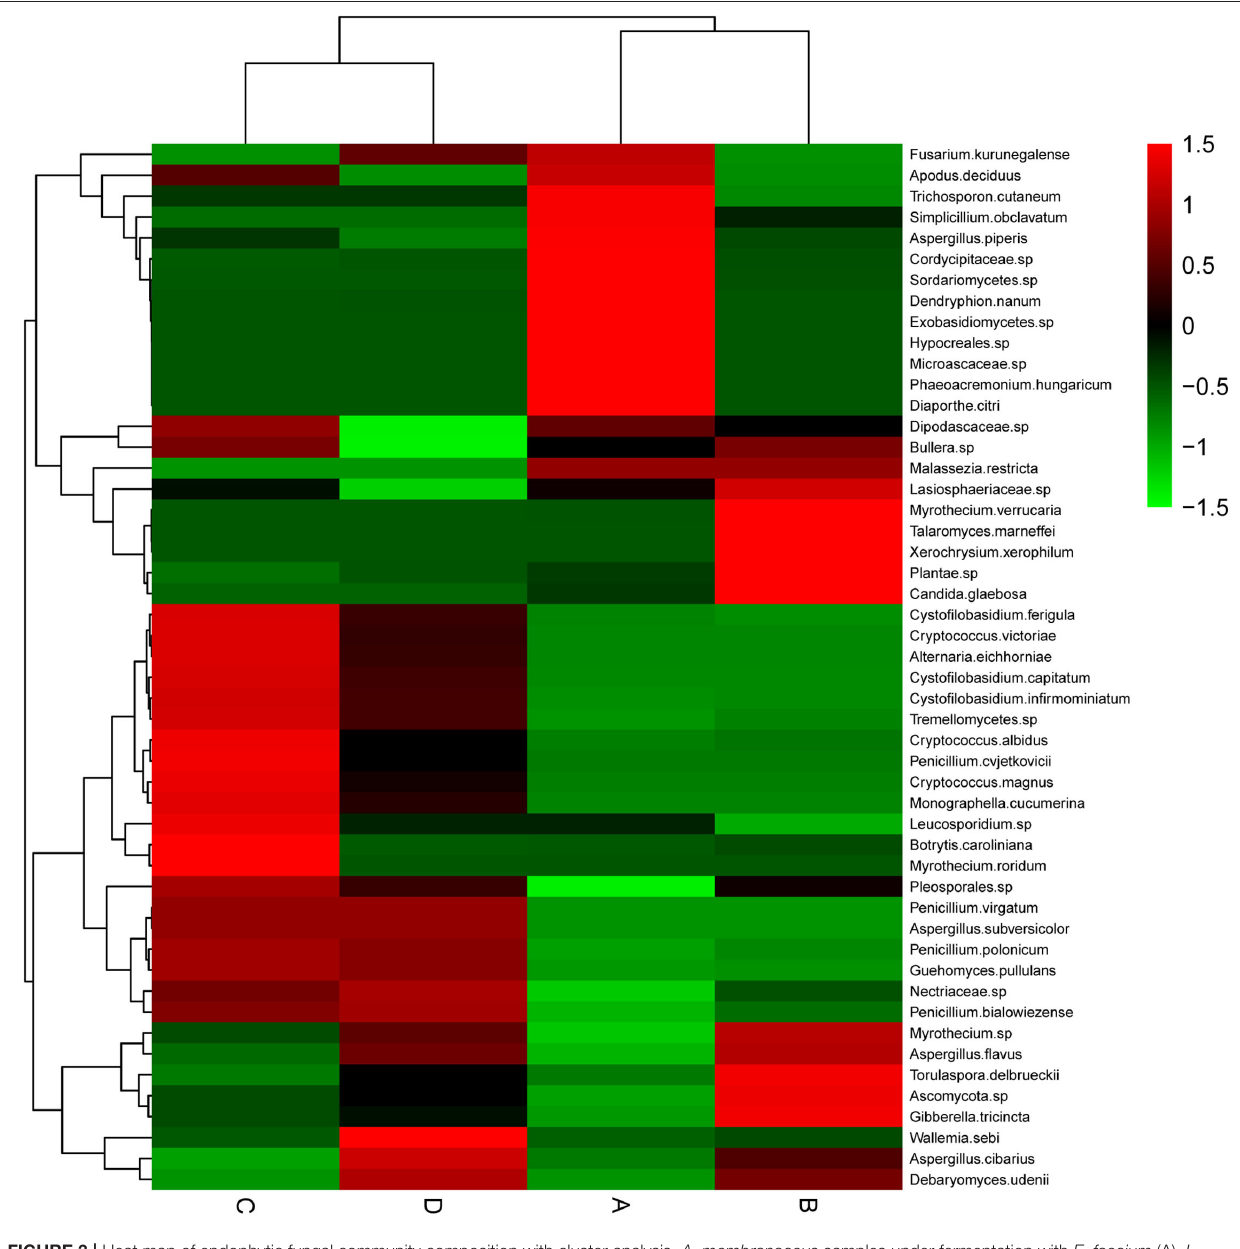
and Cystofilobasidium . Moreover, L. plantarum -fermentation of A. membranaceus significantly increased the abundance of unclassified